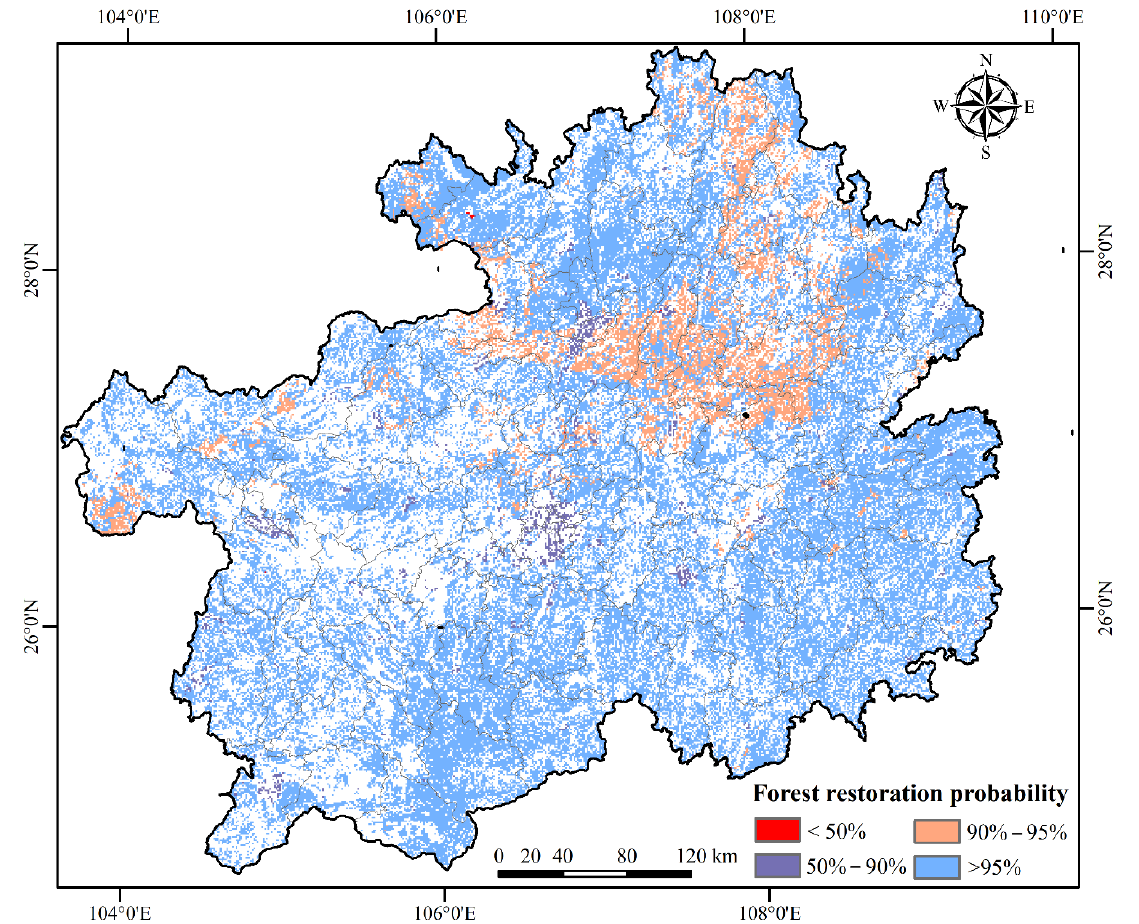
Figure 9. Distribution of the forest-restoration probability.